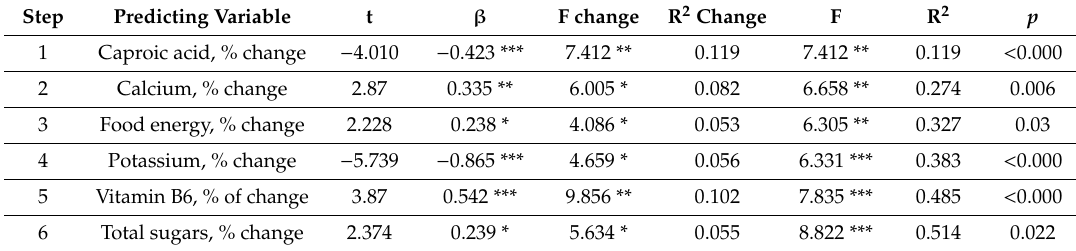
Table 3. Linear regression model (stepwise) for the prediction of BMI loss in relation to several nutritional features / components and energy